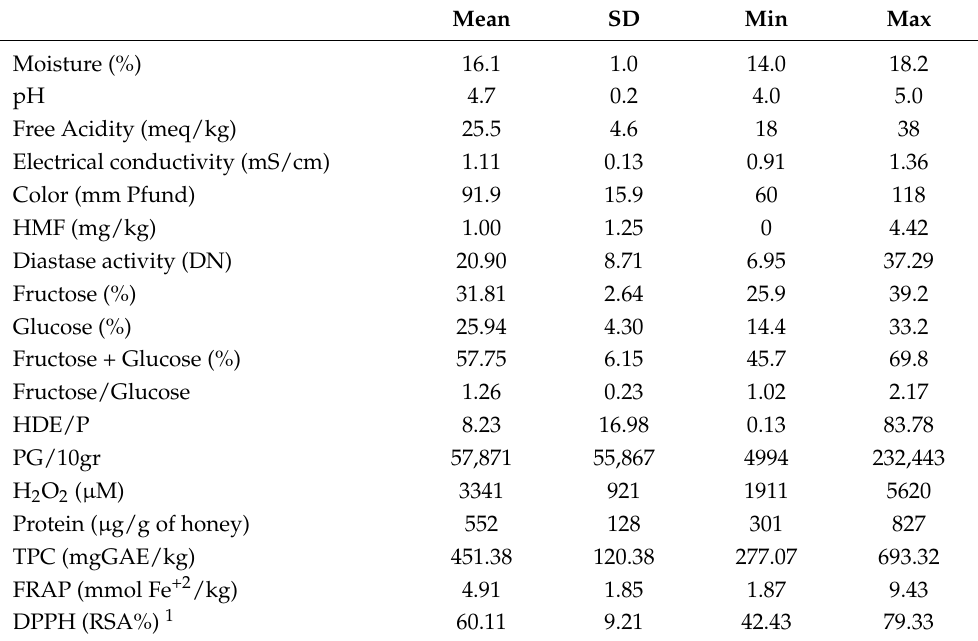
Table 1. Mean values of physicochemical